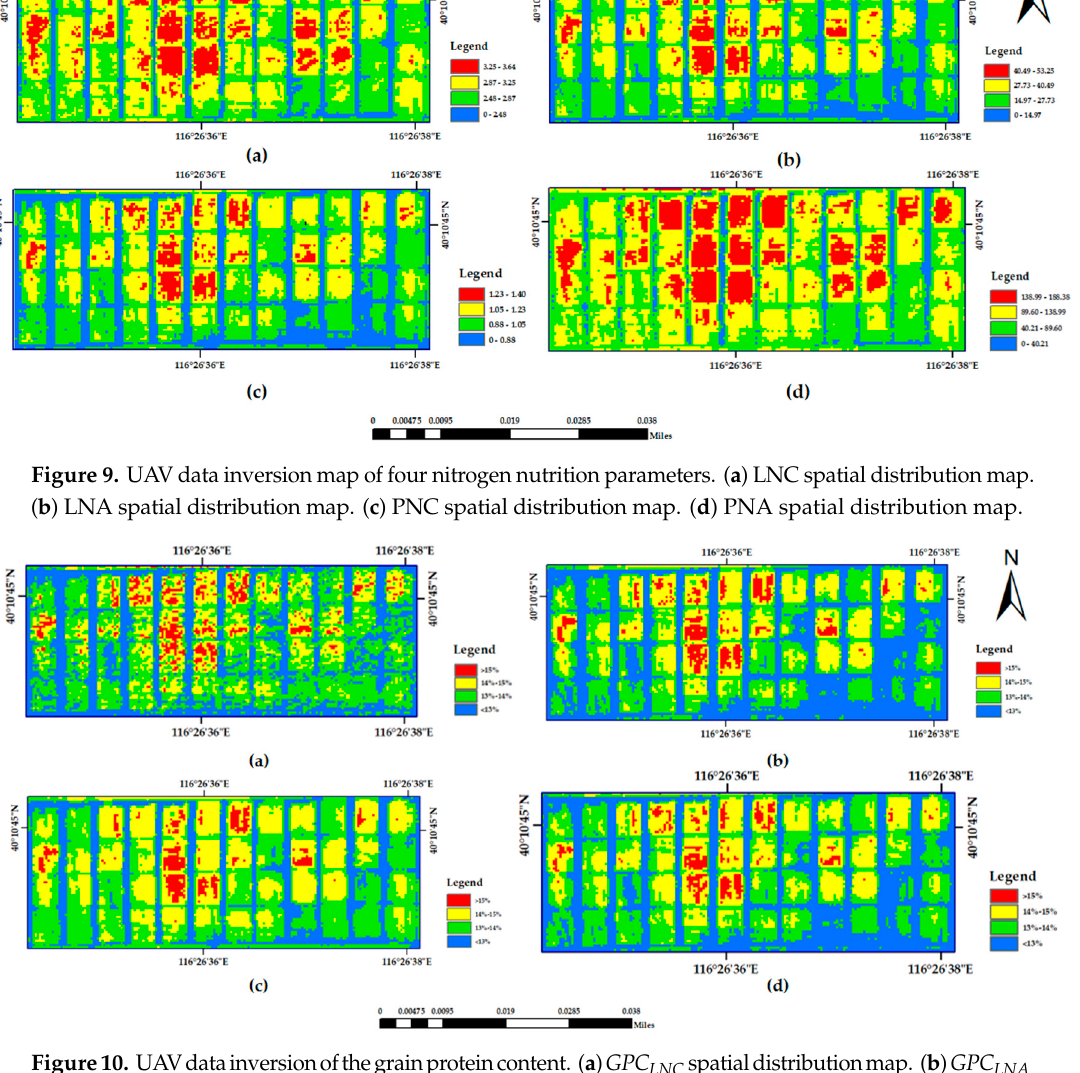
Table 11. Normalized root mean square error (nRMSE) of four nitrogen nutrition parameter models based on the different spatial resolution UAV images.